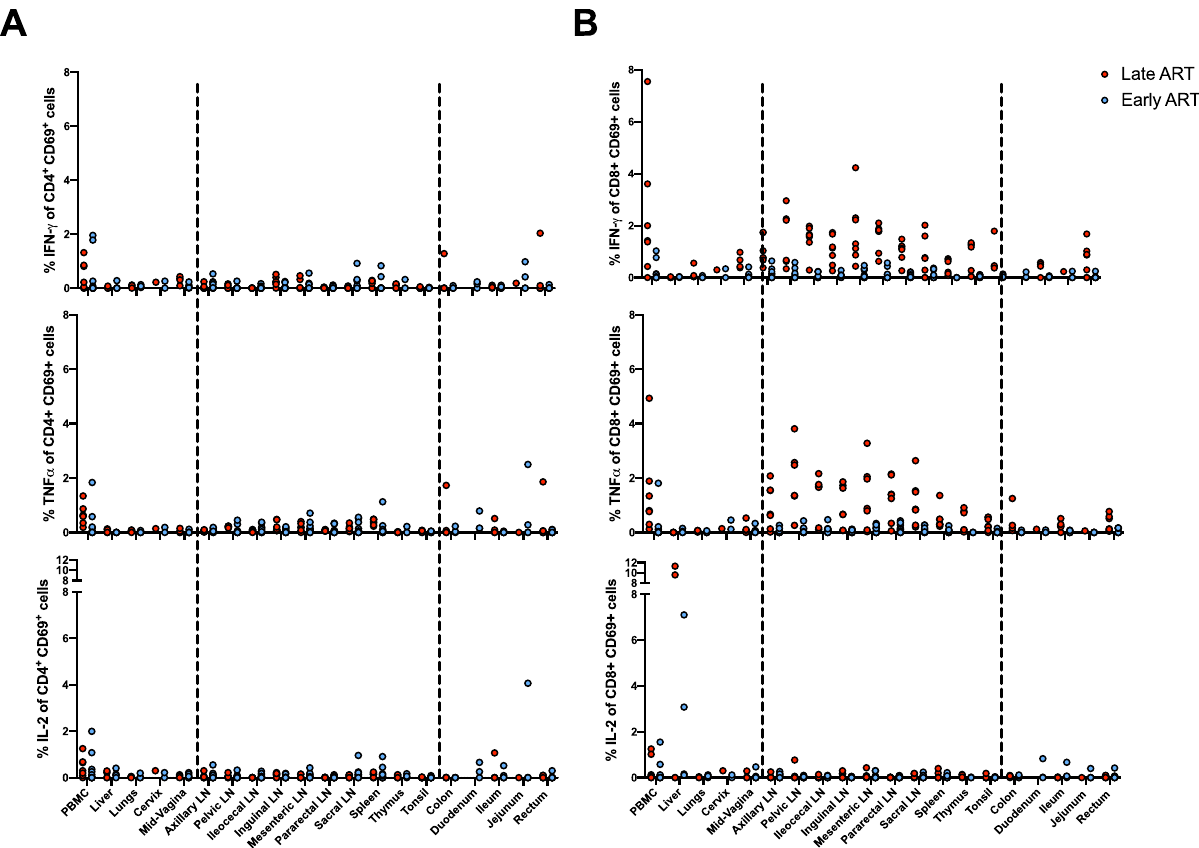
Fig. 5 T lymphocyte cytokine responses in ART-suppressed tissues. A , B SIV-Gag speci fi c IFN- γ , IL-2, and TNF α responses in CD69 + CD4 + ( A ) and CD8 + ( B ) T cells at necropsy following 1 year of ART for the Late ART monkeys (red dots) and Early ART monkeys (blue dots). Colored dots refer to individual animals. All samples with approximately 2,000 or more CD69 + cells were kept for further analysis. Flow cytometry gating strategy used is illustrated in Supplementary Fig. 7. IFN- γ , Interferon gamma, IL-2, Interleukin 2, TNF α , Tumor necrosis factor